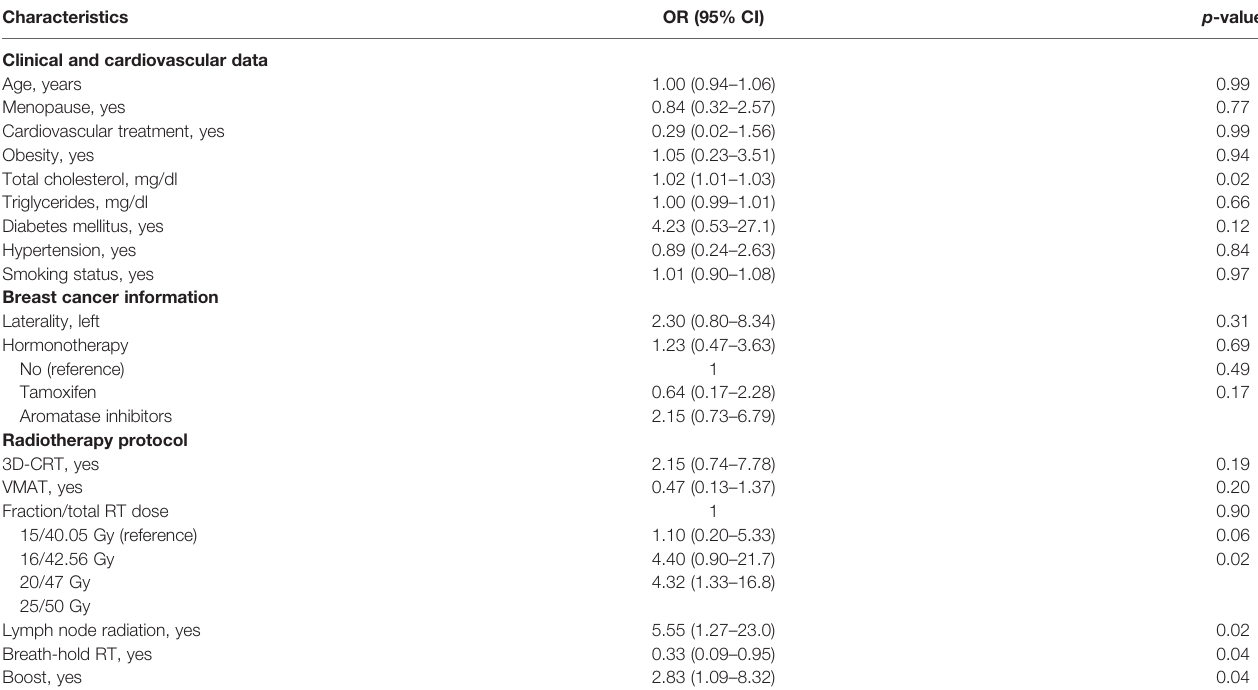
TABLE 5 | Univariate logistic regressions exploring the relationship between baseline characteristics and a relative reduction of GLS >15% occurring 6 months after BC RT.